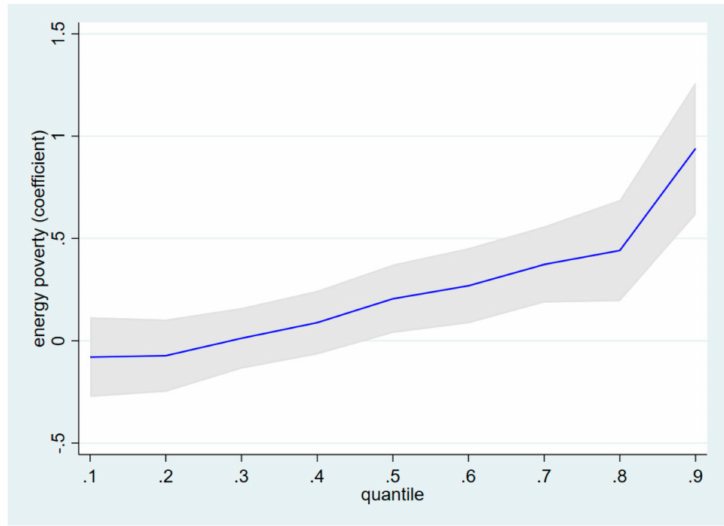
Figure A1. Quantile regression estimates for the impact of energy poverty (EP2) on depression. Notes: the x -axis denotes the 9 conditional quantiles of the CES-D8 depression scores, and the y -axis presents the coefficient estimates of energy poverty measure (EP2). Shaded areas correspond to 95% confidence intervals of quantile estimation.